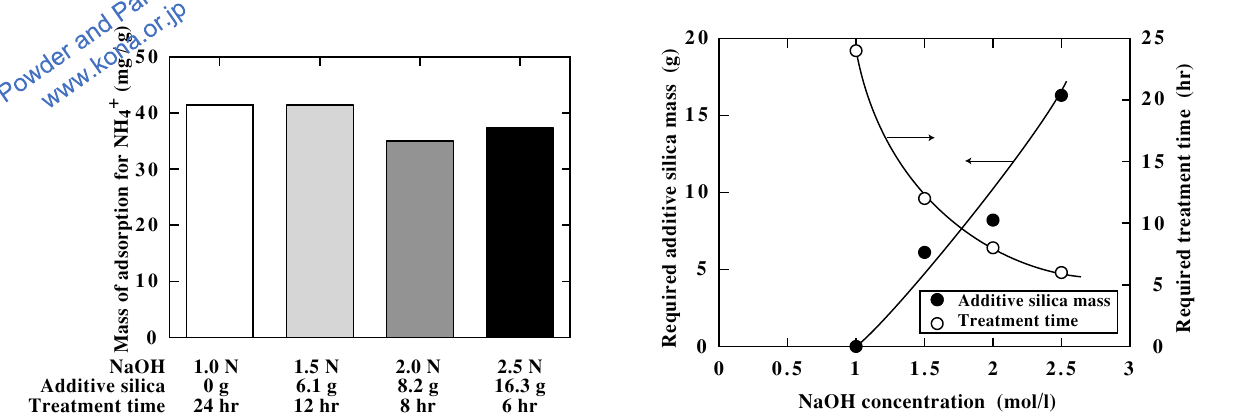
Fig. 14 Required additive silica mass and required treatment time for synthesizing phillipsite as a function of NaOHaq. concentration (Fly ash + Silica powder =